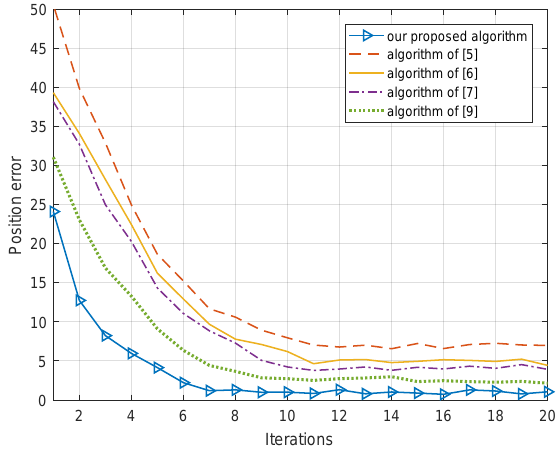
Figure 6. Convergence